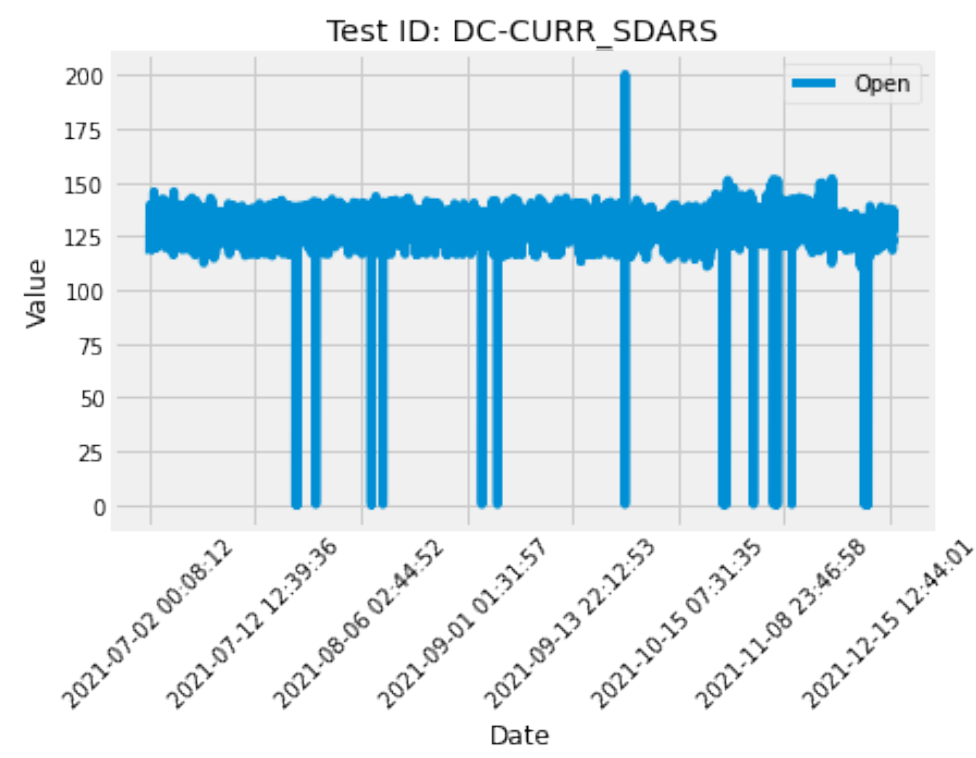
Figure 10. Graph for DC–CURR_SDARS tested